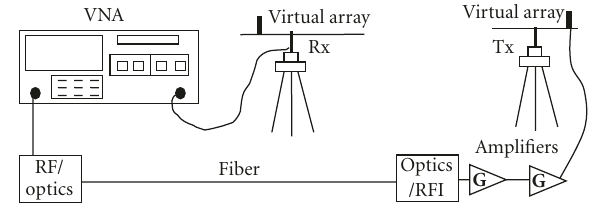
Figure 2: Principle of the channel sounder